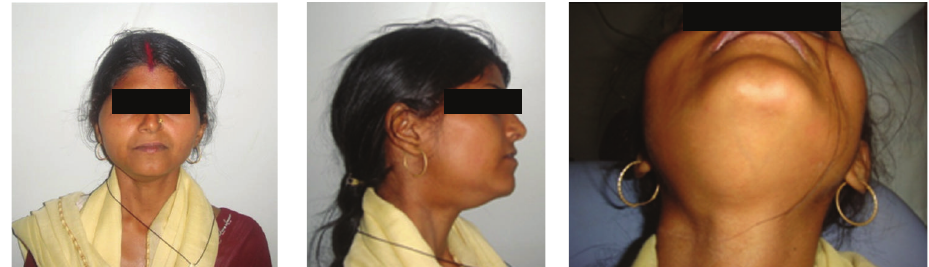
Figure 1: 23-year-old female, exhibiting a swelling involving the entire right side of the cheek and floor of the mouth.